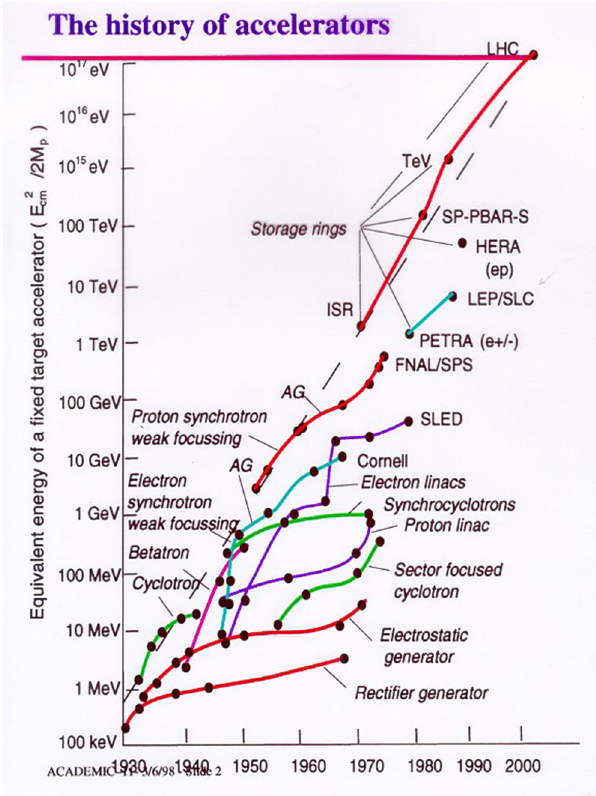
FIG. 3. Energy evolution of particle accelerators: Livingston chart, first published by Livingston